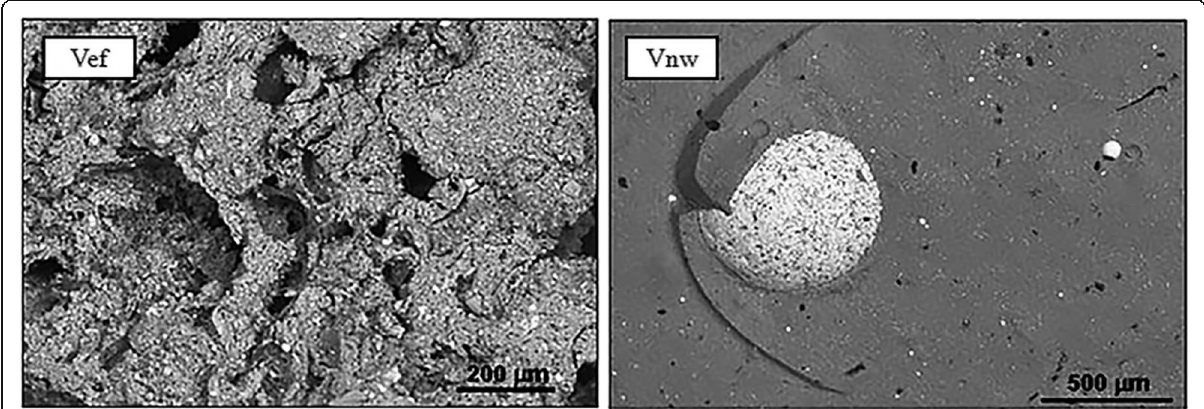
Fig. 6 SEM microphotographs of the solid residues obtained in the electric (Vef) and microwave furnaces (Vmw) [39]